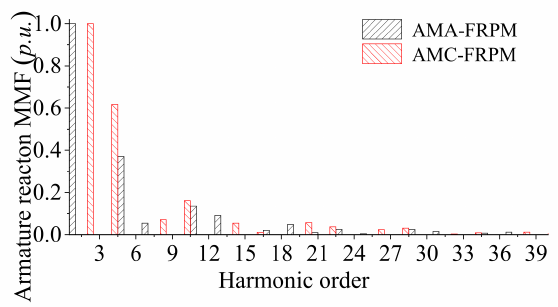
Figure 12. Armature reaction MMF harmonic distribution for AM-FRPM